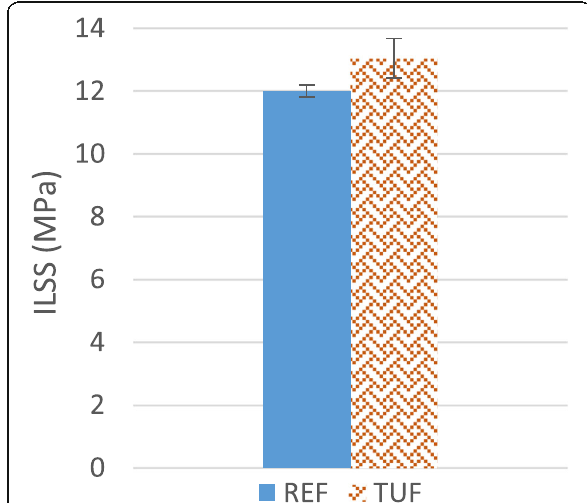
Fig. 7 Interlaminar shear strength for REF and TUF